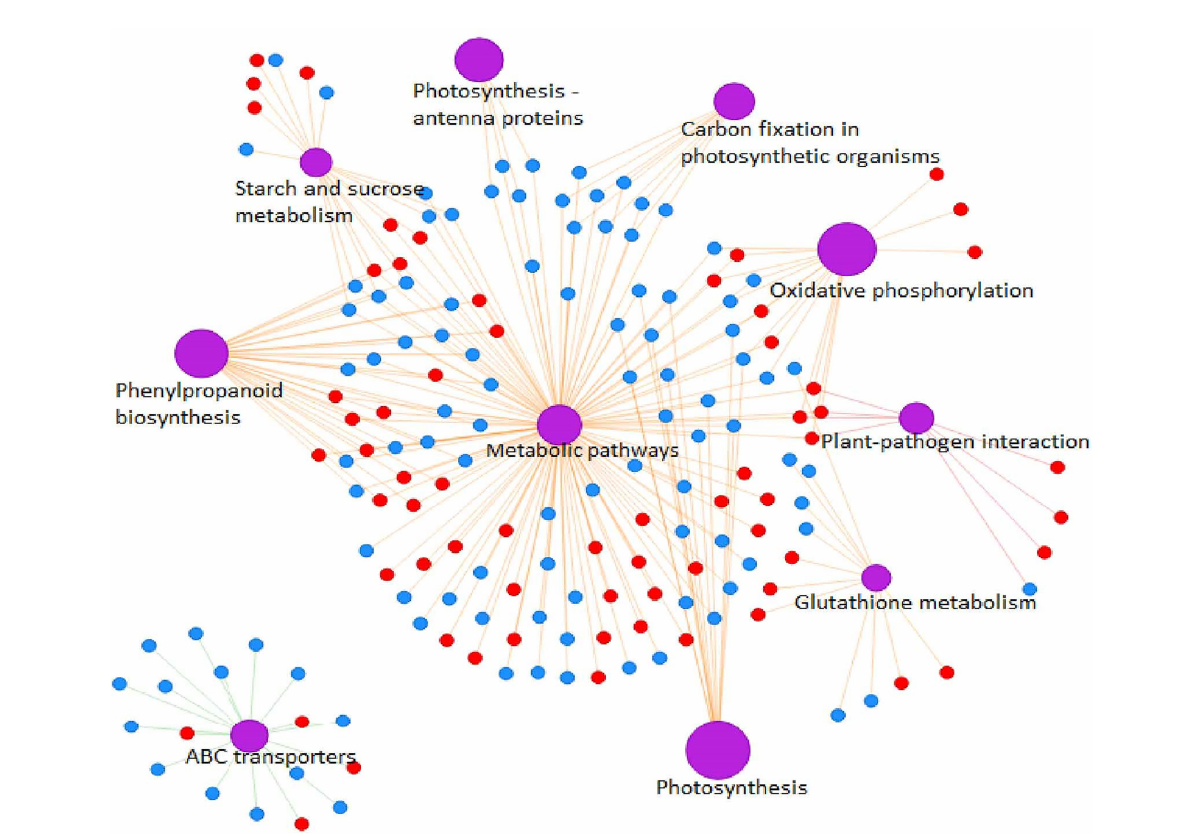
FIGURE 9 Protein–protein interaction (PPI) network analysis of the DEPs between long and short wheat radicles. Red circles represent upregulated proteins and blue circles downregulated proteins. Edges with purple represent classes of KEGG